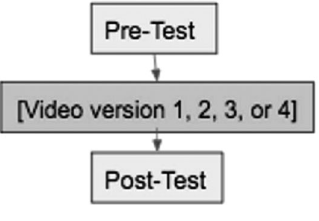
FIG. 7. Experimental design.